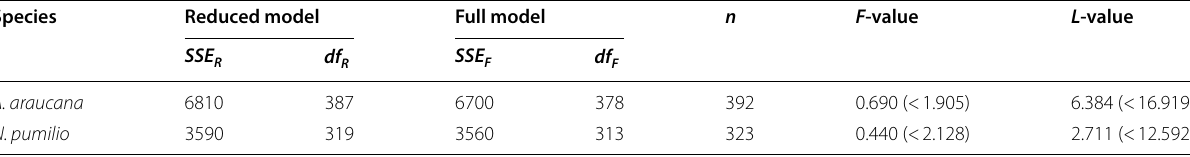
Table 5 Results of statistical tests comparing the height-diameter relationship of A. araucana and N. pumilio among different sites